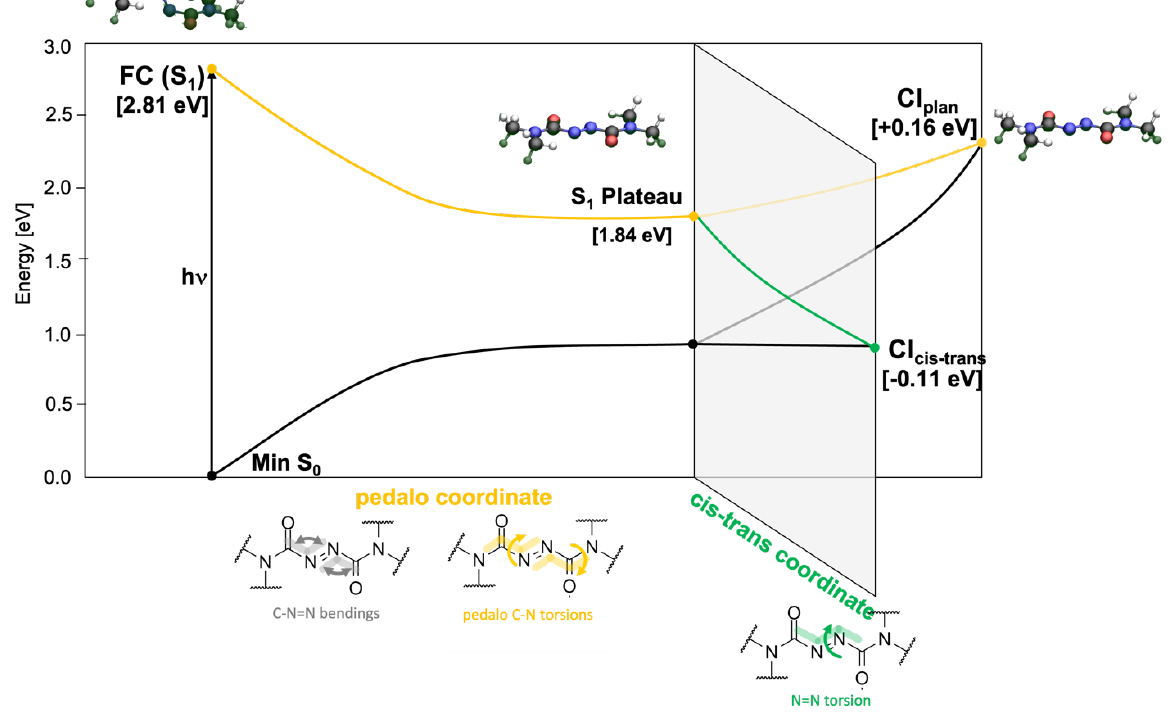
Figure 3. Scheme of the potential energy profile connecting the FC region of the S 1 state to the S 1 /GS CI seam, obtained at QM(CASPT2)/MM level in gas phase based on relaxed scans along torsion and bending coordinates reported in Table S1 in the SI section.